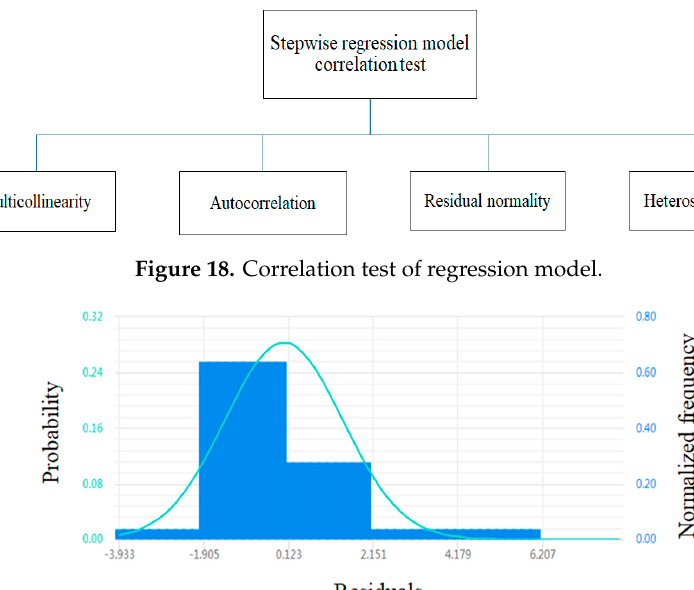
Figure 19. Normal distribution of residual data.